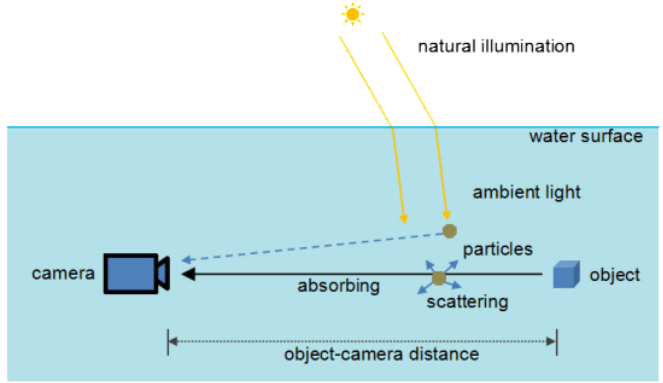
Figure 1. Underwater imaging model.